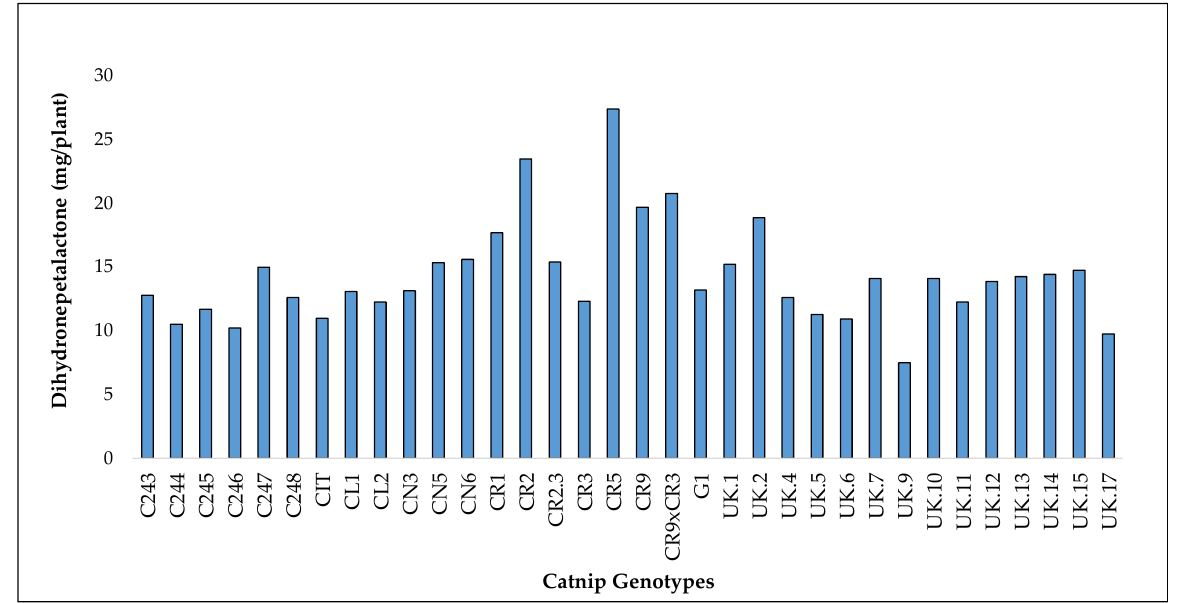
Figure 8. Accumulated yields of dihydronepetalactone in catnip genotypes after 3 successive harvests (2017 1 and 2 and 2018). Pittstown, NJ, USA. Combined, genotype UK9 had the lowest DHNL at 7.5 mg/plant while CR5 had the highest at 27.4 mg/plant. DHNL was the highest for 2018 and when the values were combined for both years. The observed values for NT and DHNL are lower than those of NA (Figure 8, Table S5). Overall CR9 × CR3 had the highest biomass (463.2 g/plant), CR9 had the highest NA (3638.0 mg/plant), UK.2 had the highest NT (90.0 mg/plant) and CR5 had the highest DHNL (27.4 mg/plant) (Figures 6 – 9). Accumulated data shows interesting agronomic po- tential for CR9, CR9 × CR3 and CR5 for the production of high-value compounds for phar- maceutical purposes.